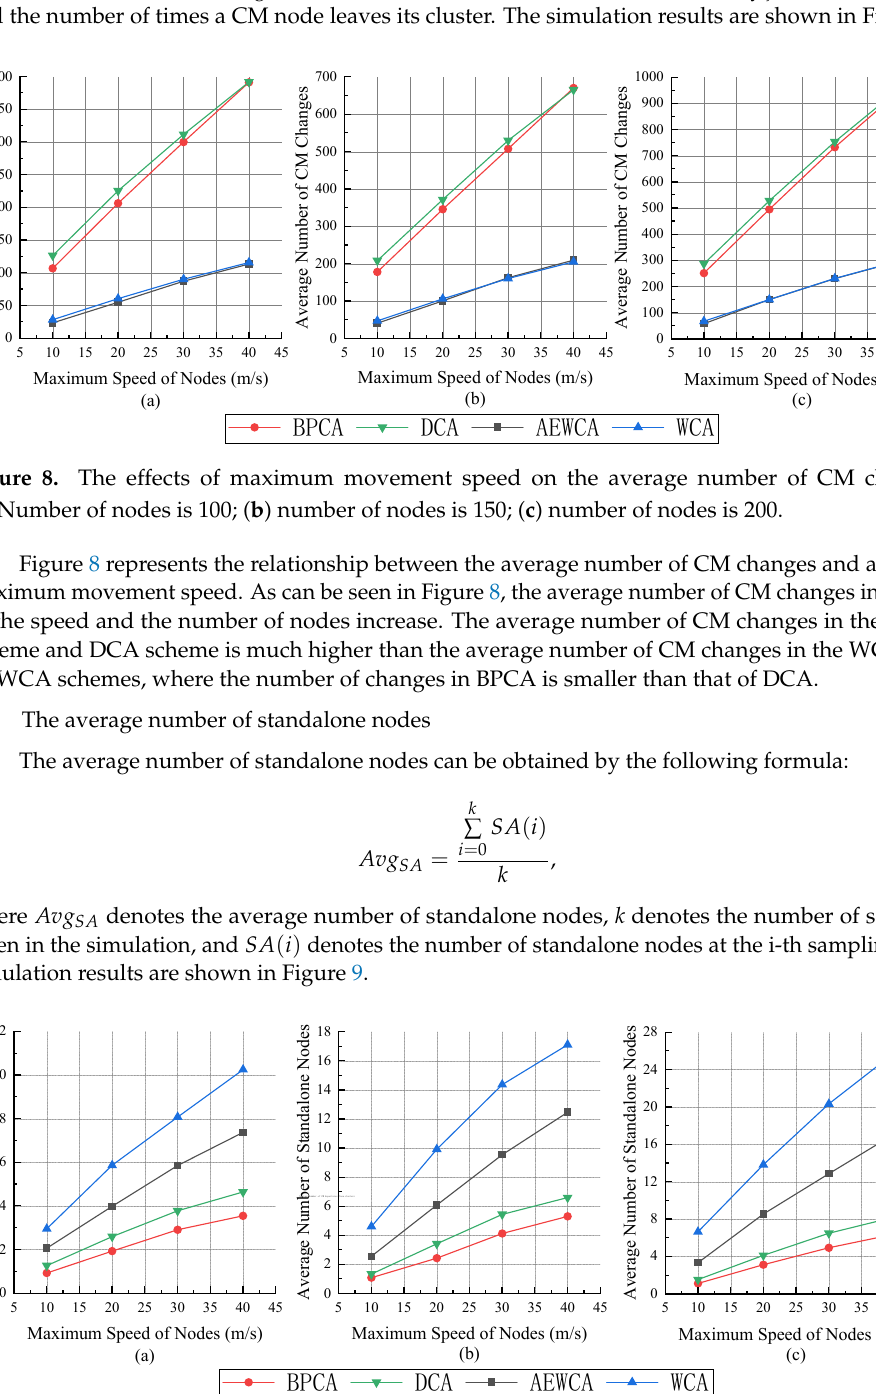
Figure 7. The effects of maximum movement speed on the average number of CM detached from clusters. ( a ) Number of nodes is 100; ( b ) number of nodes is 150; ( c ) number of nodes is 200. Figure 7 represents the relationship between the average number of CM detached from clusters and a node’s maximum movement speed. It can be seen in Figure 7 that the number of the average number of CM detached from clusters increases with the increasing number of nodes and node speed. The average number of CMs that breaks away from clusters in the BPCA scheme is the lowest compared to other algorithms.